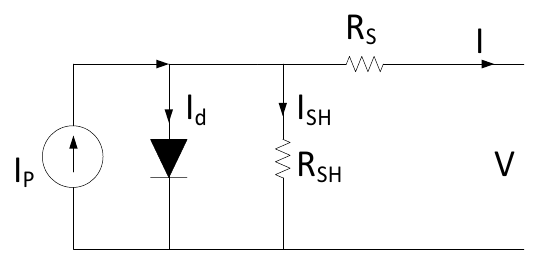
Figure 1. Single-diode model PV system: (i) equivalent circuit diagram; (ii) symbolic